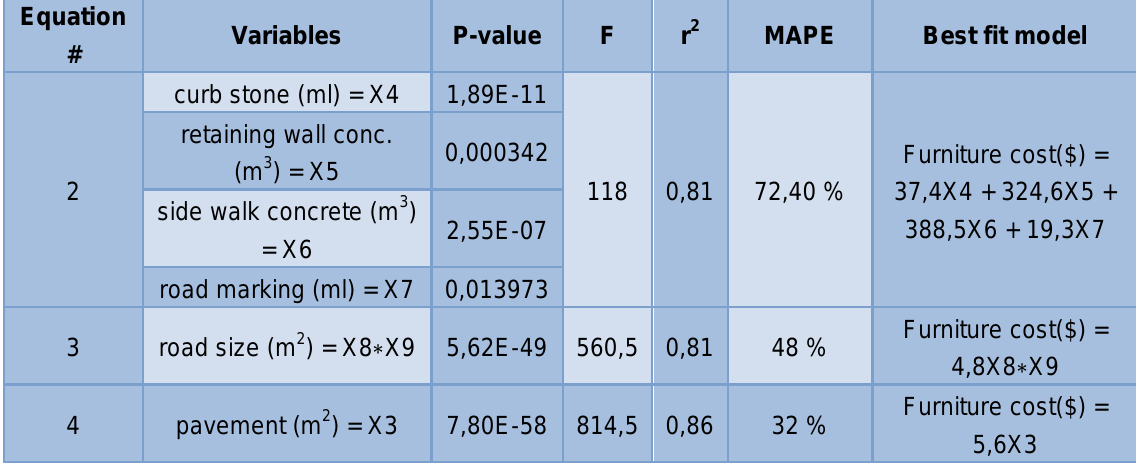
Table 10 Cost estimating models for furniture